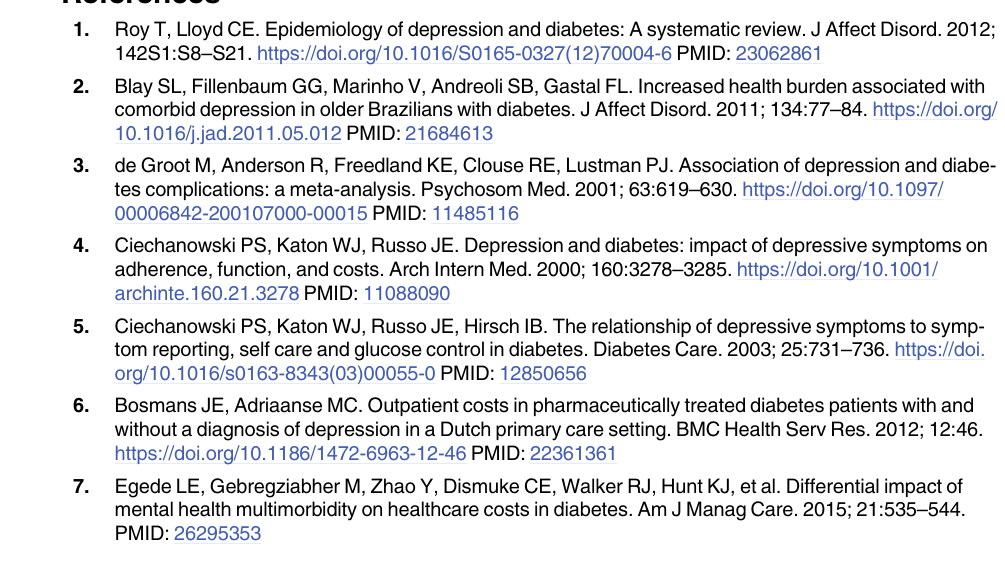
S2 Table. SPIRIT 2013 checklist: Recommended items to address in a clinical trial protocol and related documents �